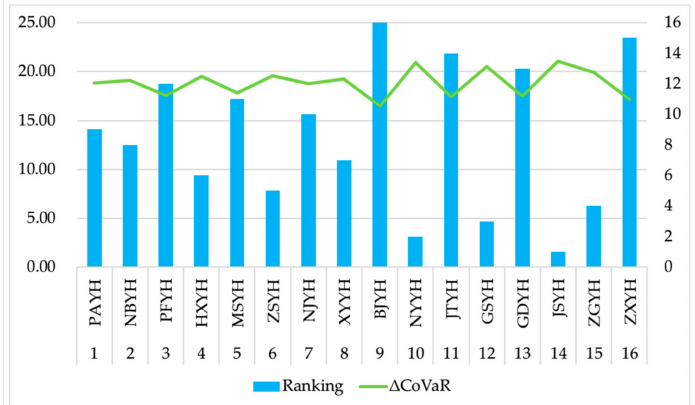
Figure 17. Measurements and rankings of dynamic ∆ CoVaRs (The left axis and right axis refers to the value and ranking of the dynamic ∆ CoVaR (the di ff erence between the Conditional Value at Risk (CoVaRs) when the banking system is in distress and in a normal state) of each bank, based on the modified dynamic model which incorporates the e ff ects of Fintech and non-bank financial institutions during the sample period of 2015–2018) (overall analysis, modified